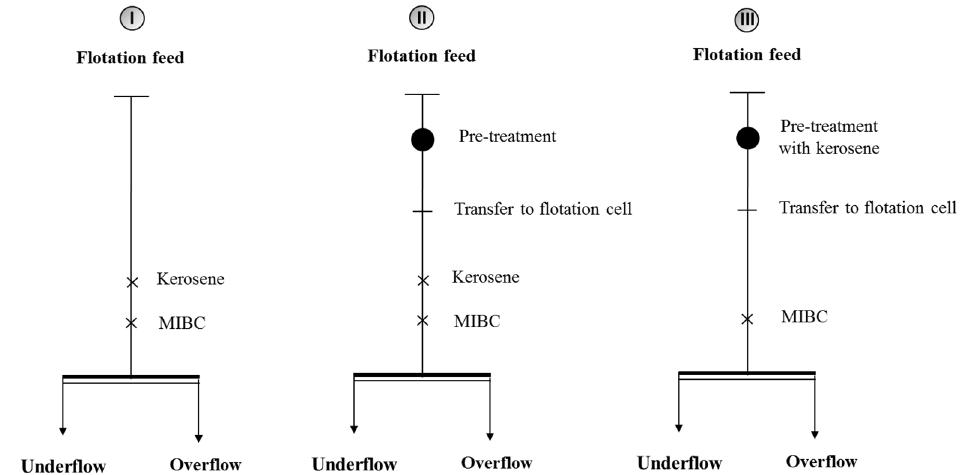
Figure 2. The three flow diagrams for the flotation experiments. ( I ) No pre-treatment, ( II ) With pre-treatment, ( III ) Kerosene added during the pre-treatment.